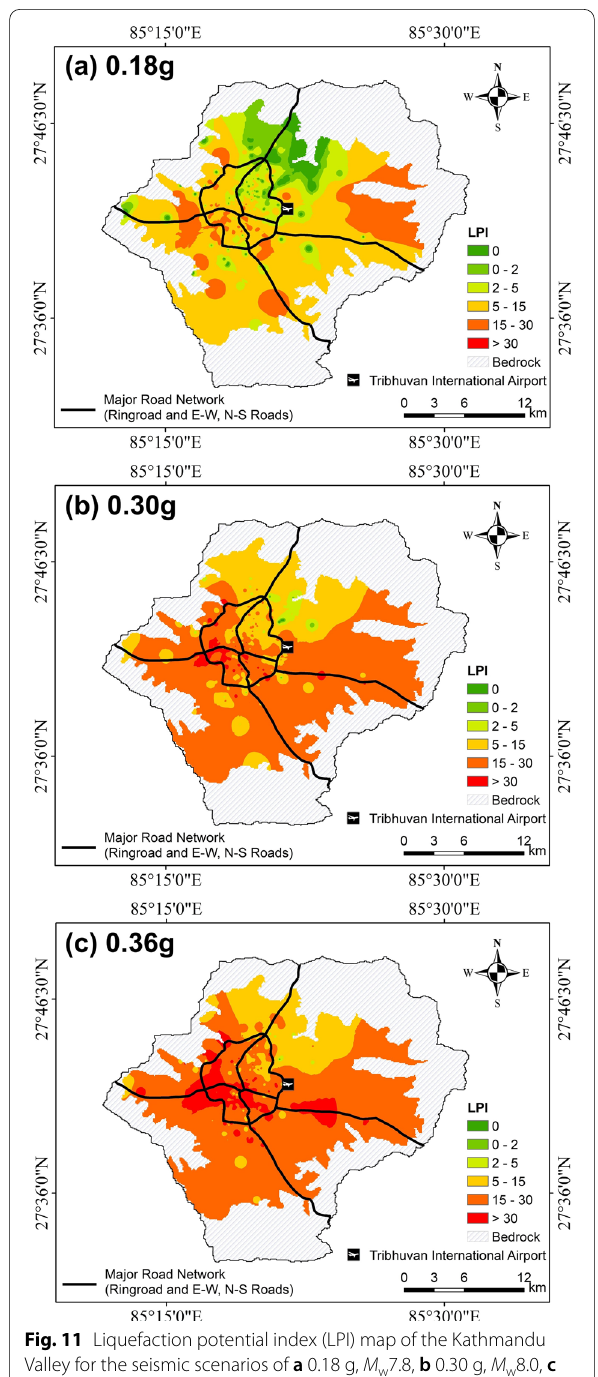
Fig. 11 Liquefaction potential index (LPI) map of the Kathmandu Valley for the seismic scenarios of a 0.18 g, M w 7.8, b 0.30 g, M w 8.0, c 0.36 g, M w 8.4 based on Iwasaki et al. (1982)